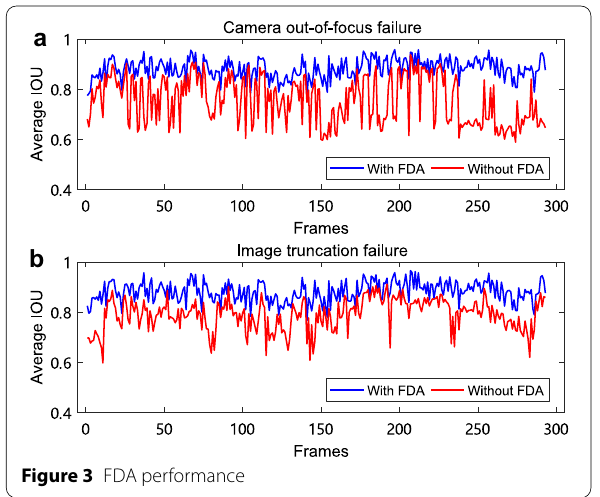
Figure 3 FDA performance